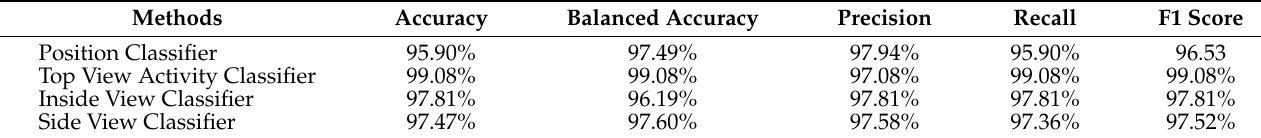
Table 4. Inception model accuracy if we divide and rearrange the dataset where the difference between classes is higher.